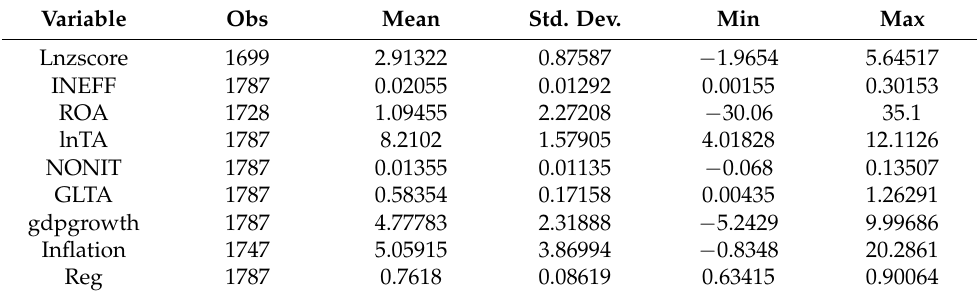
Table 5. Descriptive Statistics (Banks in Countries with UK origin).